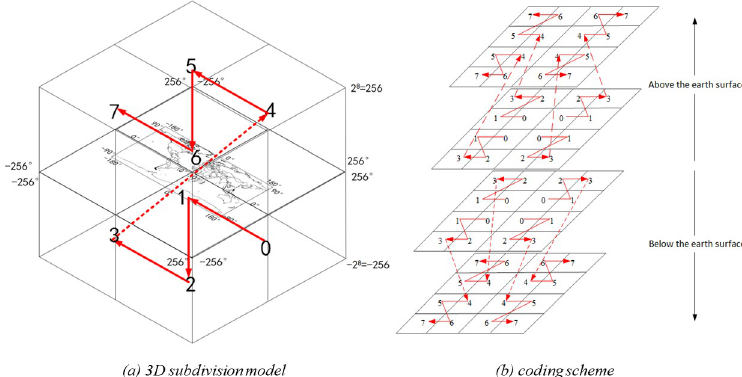
Fig 1. Structure of GeoSOT global subdivision grids. A dichotomy algorithm is applied in the three directions of longitude, latitude and altitude. The binary digit in the code is assigned 1 if the original data is higher than the mean value at the corresponding level; otherwise, the binary digit in the code is assigned 0. The 1st-level grid encoding order is shown in subfigure (a). The grids at each level below the 1st level should be encoded based on the upper-layer grid codes. Specifically, in the height direction, the encoding order extends from the lower level to the upper level, and the Z-order is adopted to continue encoding at the same level. The direction of Z-order coding is determined by the locations of the 1st-level grids. An example of the encoding order is shown in subfigure (b).